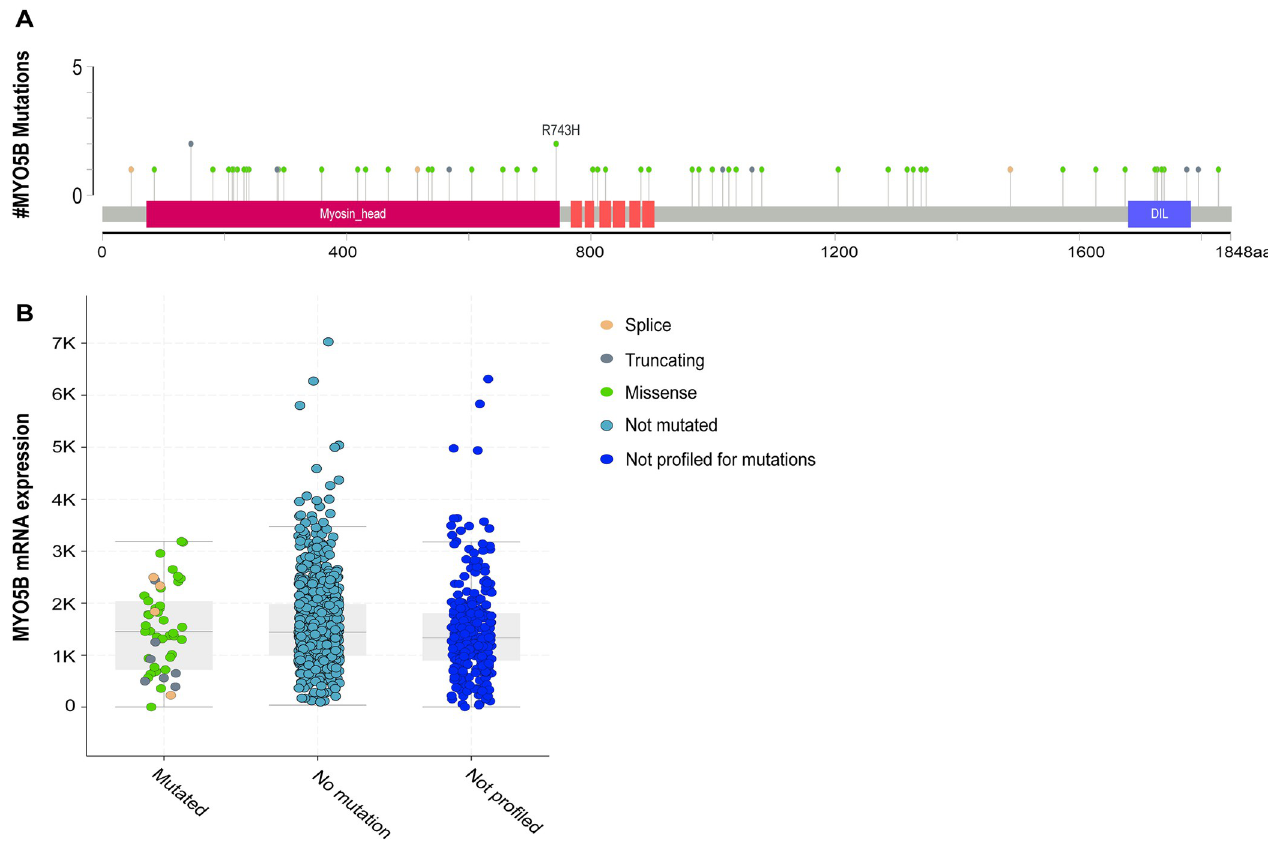
Fig 2. MYO5B is not commonly mutated in UCEC patients. A. Graphic of the MYO5B gene with lollipops identifying mutation sites B. MYO5B mRNA expression in the context of mutations.